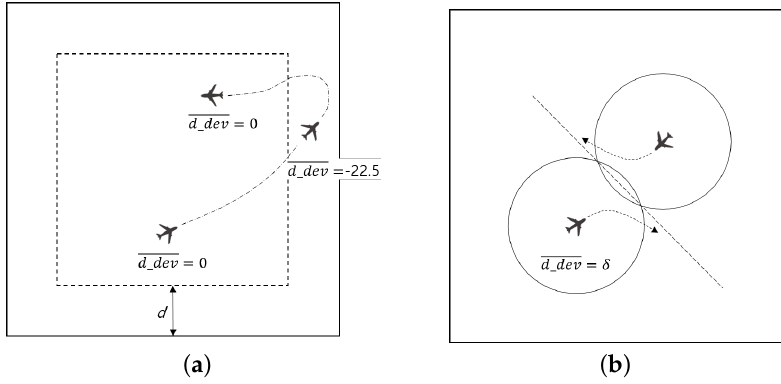
Figure 5. Examples of changing direction: ( a ) Enhanced Gauss–Markov model; and ( b ) Enhanced Gauss–Markov with overlap avoidance model.